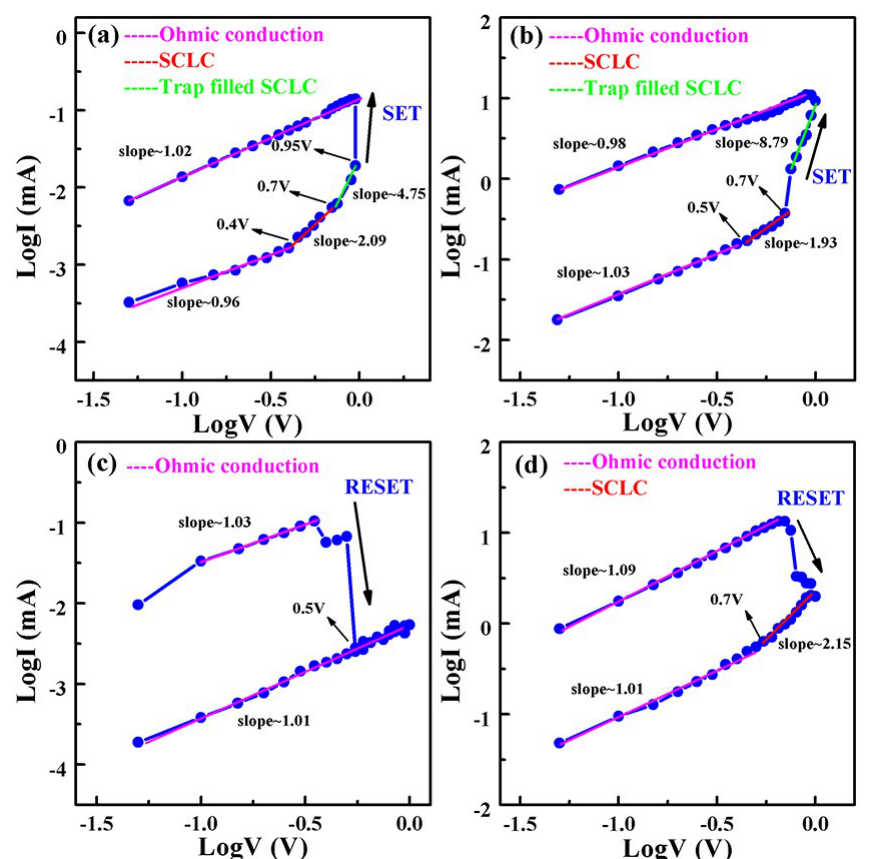
Figure 7. log I –log V plots in ( a ) Au/HfO 2 /Pt/Ti/SiO 2 /Si and ( b ) Au/HfO 2 /Pt/mica RRAM devices under positive voltage; ( c ) Au/HfO 2 /Pt/Ti/SiO 2 /Si and ( d ) Au/HfO 2 /Pt/mica RRAM devices under under positive voltage; ( c ) Au / HfO 2 / Pt / Ti / SiO 2 / Si and ( d ) Au / HfO 2 / Pt / mica RRAM devices under negative voltage. negative